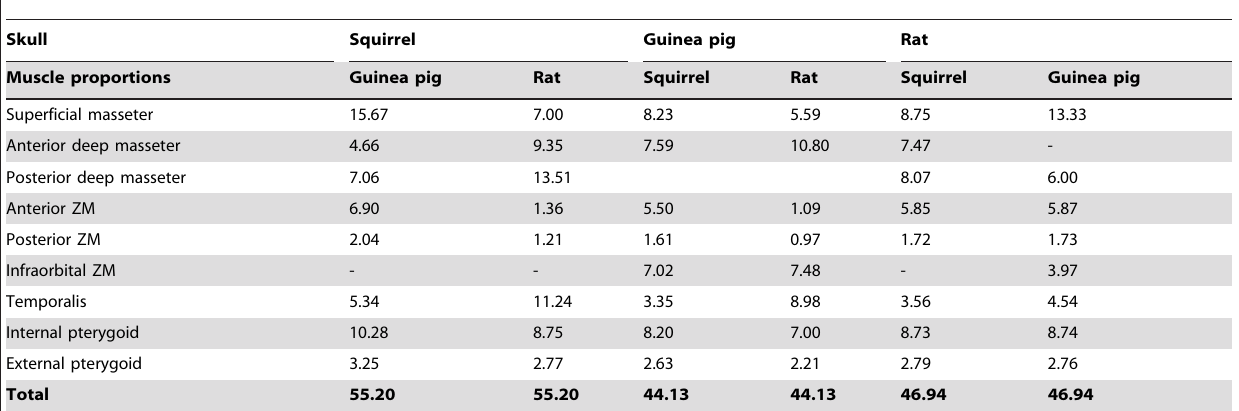
Table 4. Recalculated muscle forces (N) simulating muscle proportions of each rodent on the other two skulls.